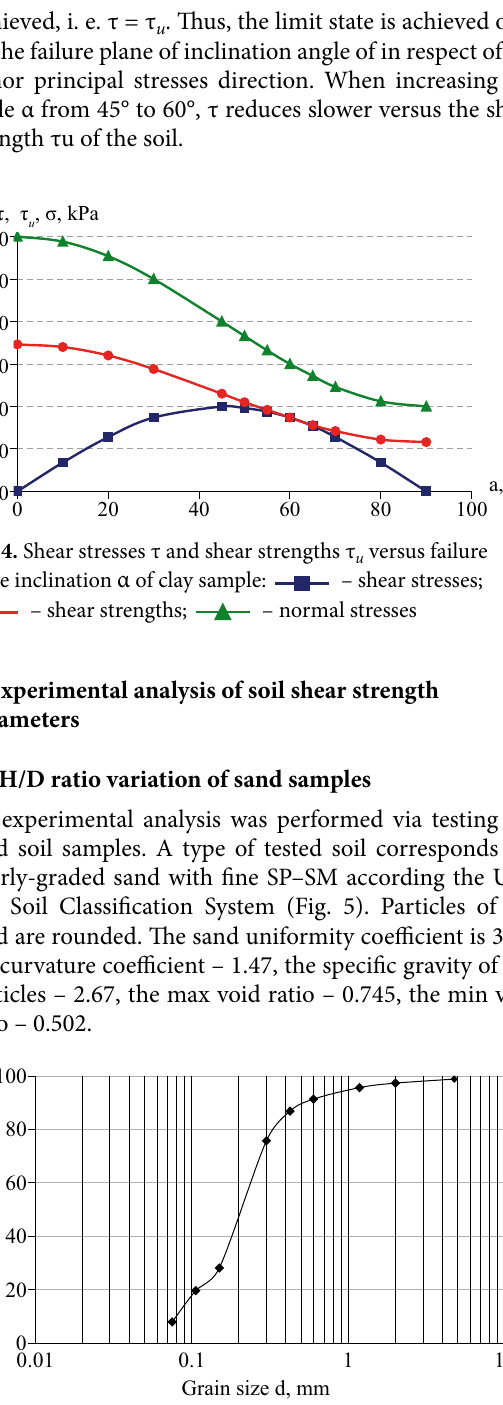
Fig. 5. Grading curve of sand